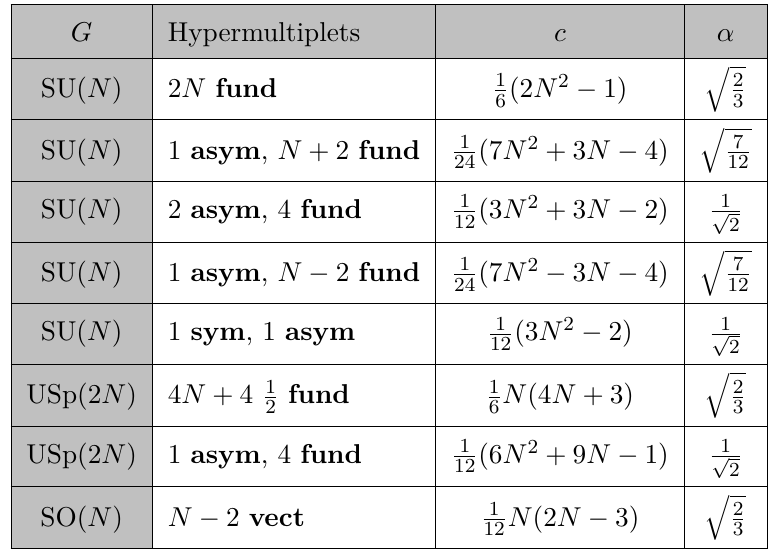
Table 1. Computation of α for d = 4 , N = 2 SCFTs with simple gauge group, to leading order in large N . We list all entries of the classification of [138] that admit large N limits, in the notation of [138].